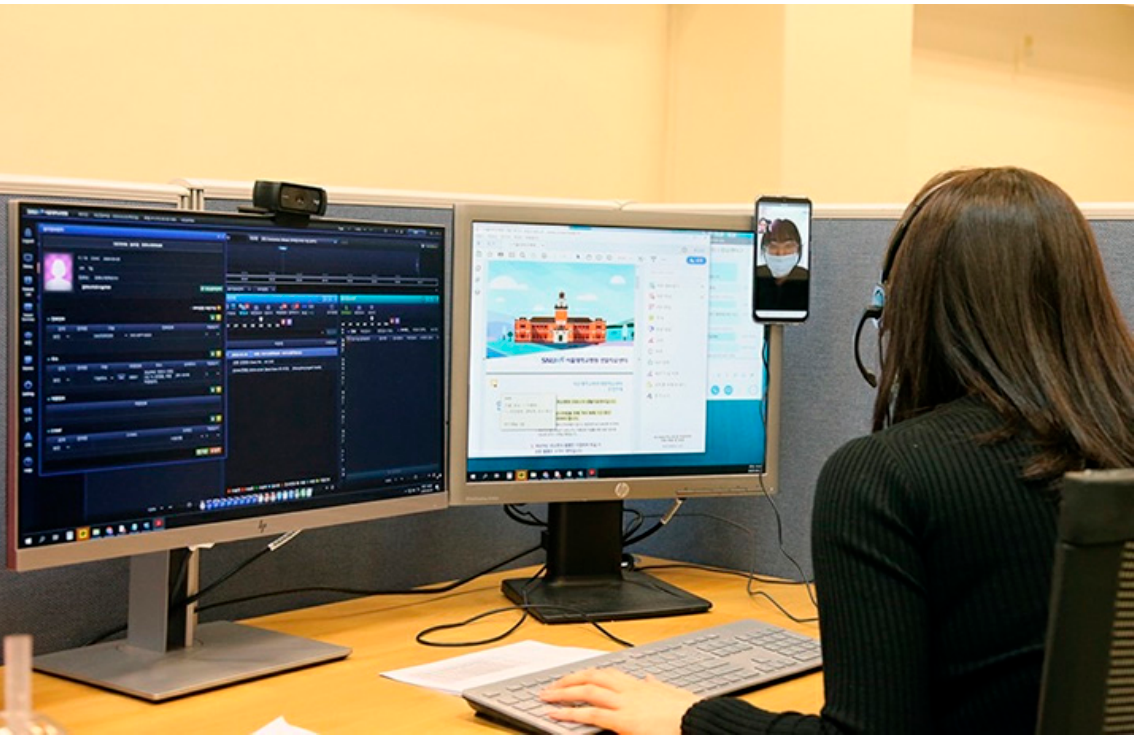
Figure 1. Providing a Telenursing Service for COVID-19 Patients.